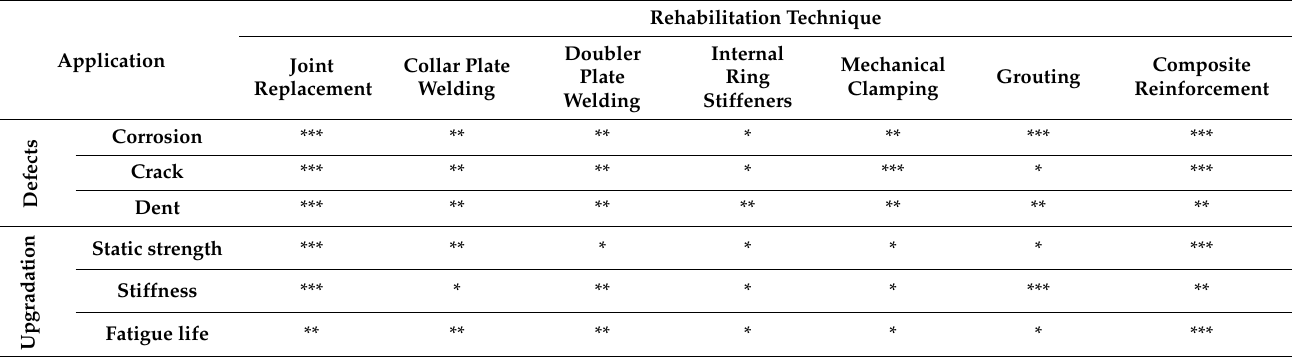
Table 2. Effectiveness of rehabilitation technique.